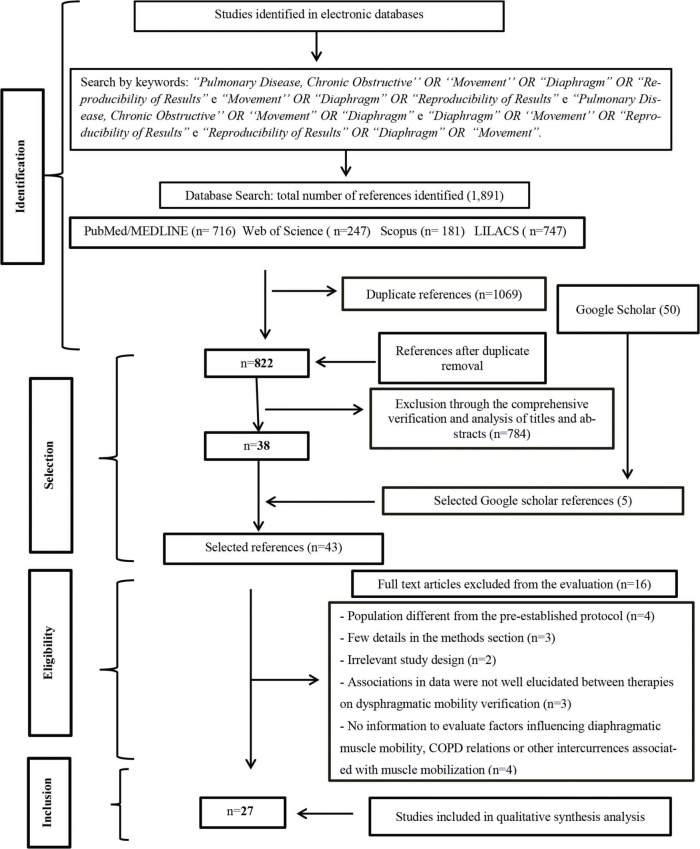
Flowchart of the selection process for the bibliographic search; the diagram is an adapted checklist (PRISMA).